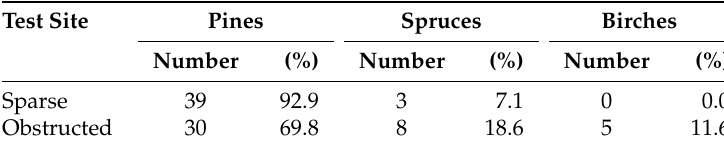
Table 2. Distribution of the tree species on the two test